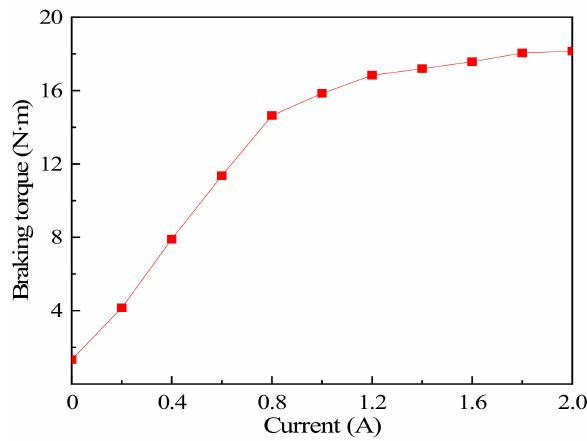
Figure 10. Simulation results of braking torque with